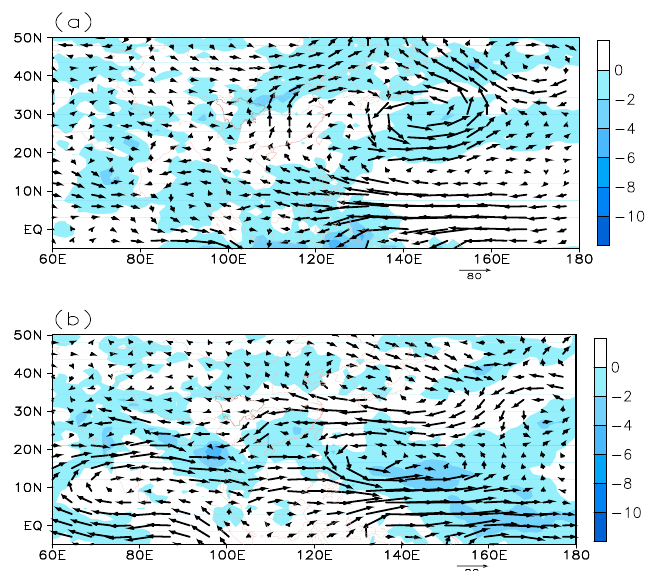
Figure 5. Anomalies of integrated water vapor flux in the whole layer (vector; unit: kg m − 1 s − 1 ) and the water vapor divergence (shaded; unit: 10 − 5 kg m − 2 s − 1 ) in ( a ) wet summers and ( b ) drought summers in the Sichuan Basin.